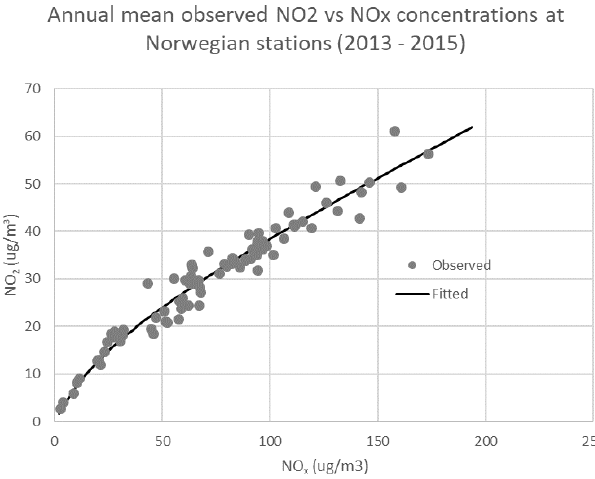
Figure 4. NO 2 versus NO x annual mean concentrations for all sta- tions in Norway in the period 2013–2015. The fitted curve is based on Eq.